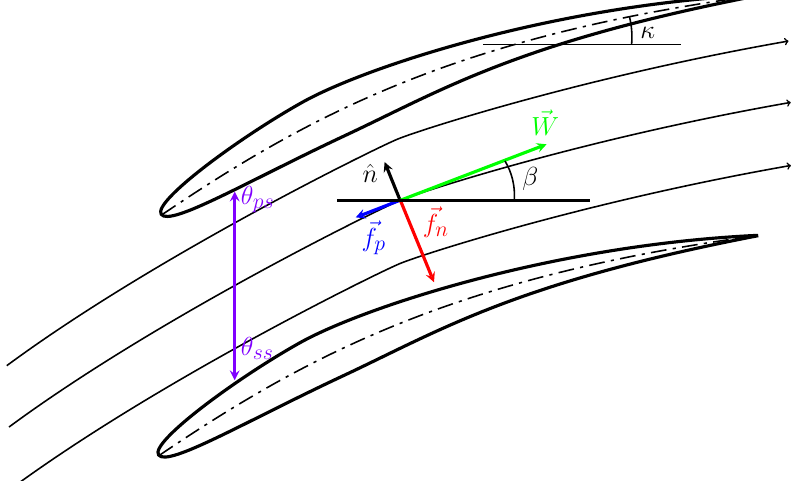
Figure 1. Blade geometric parameters and forces acting on the axisymmetric flow field. The normal component turns the streamlines, the parallel component increases entropy and adds